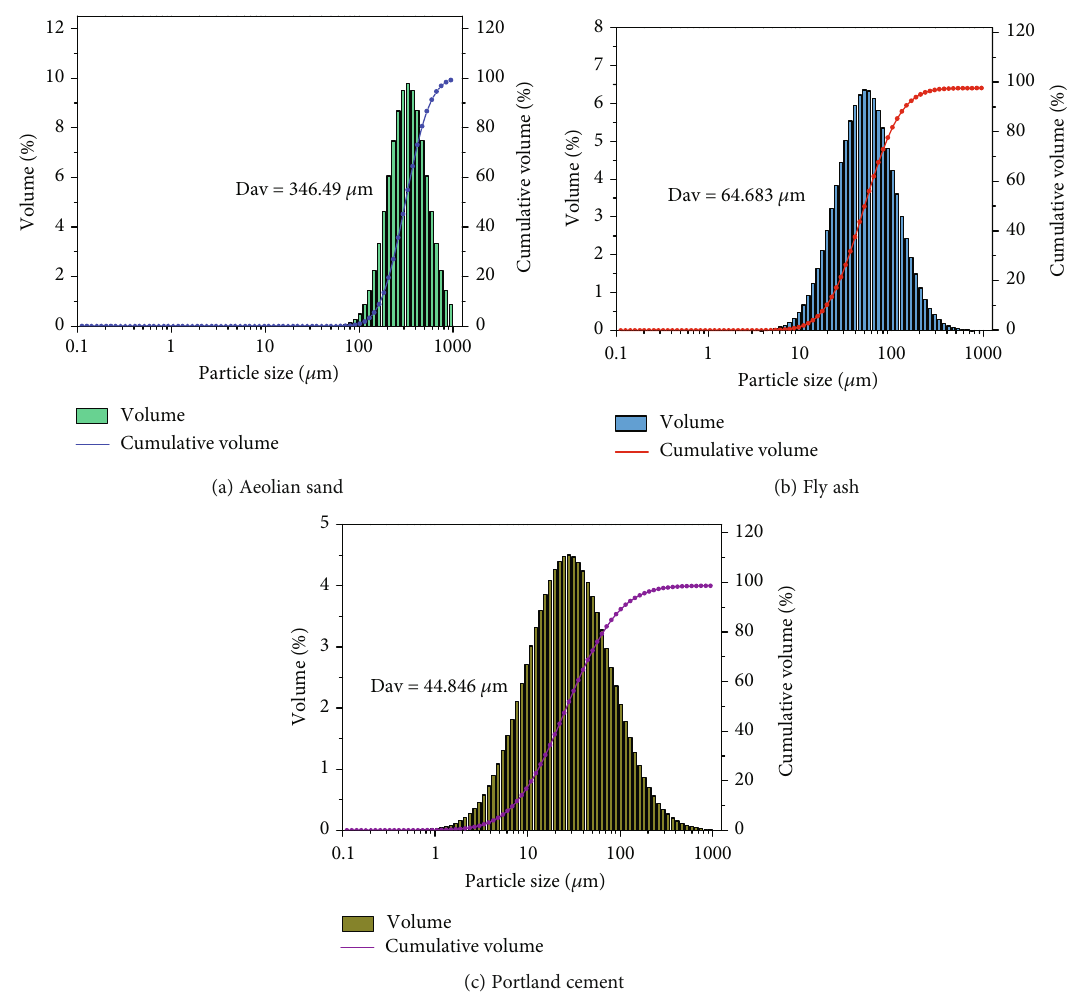
Figure 3: Particle size